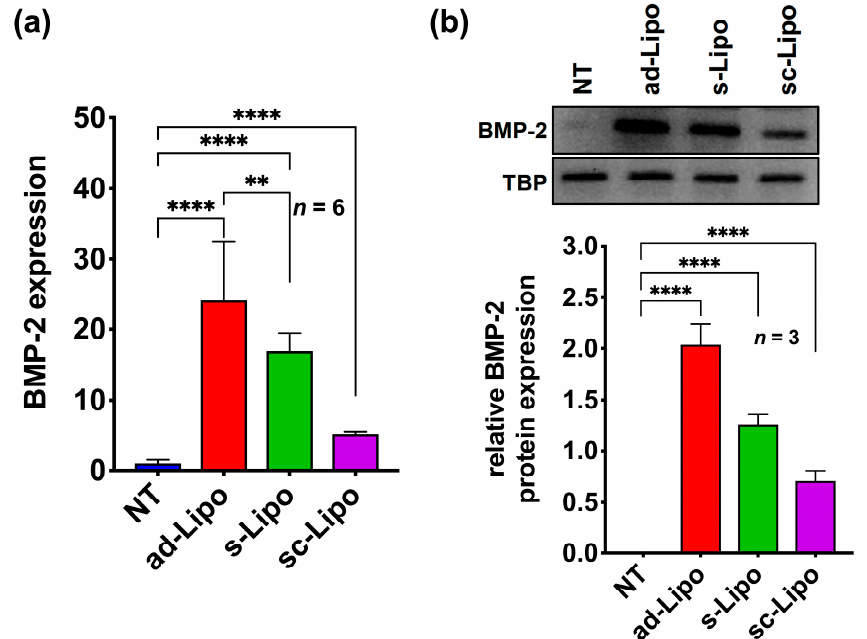
Figure 1. In vitro analysis of BMP-2 expressing plasmid DNA transfected in hMSCs in 2D cell culture. ( a ) Quantitative RT-PCR results indicating the expression levels of BMP-2 mRNA in hMSCs after 48 h of transfection. TBP was employed as an internal control to normalize BMP-2 mRNA expression. Gene expression values are stated as fold change relative to controls. Mean values ± SD of 2 independent experiments done in triplicates ( n = 6) are shown. Statistical analysis was performed using one-way ANOVA with Bonferroni’s multiple comparison corrections (** p < 0.001, **** p < 0.00001). ( b ) Western blot analysis indicating BMP-2 protein levels after 72 h of transfection. BMP-2 and TBP-specific bands were quantified by ImageJ software and BMP-2 protein expression levels were normalized to TBP values. Mean values ± SD of three independent experiments are shown. The abbreviation NT = non-treated cells; ad-Lipo = Lipofectamine TM 2000 assisted transfection with adherent cells; s-Lipo = Lipofectamine TM 2000 assisted transfection of cells in suspension; sc-Lipo = Lipofectamine TM 2000 assisted transfection of cells in suspension followed by centrifugation; TBP = TATA-binding protein (**** p < 0.0001).